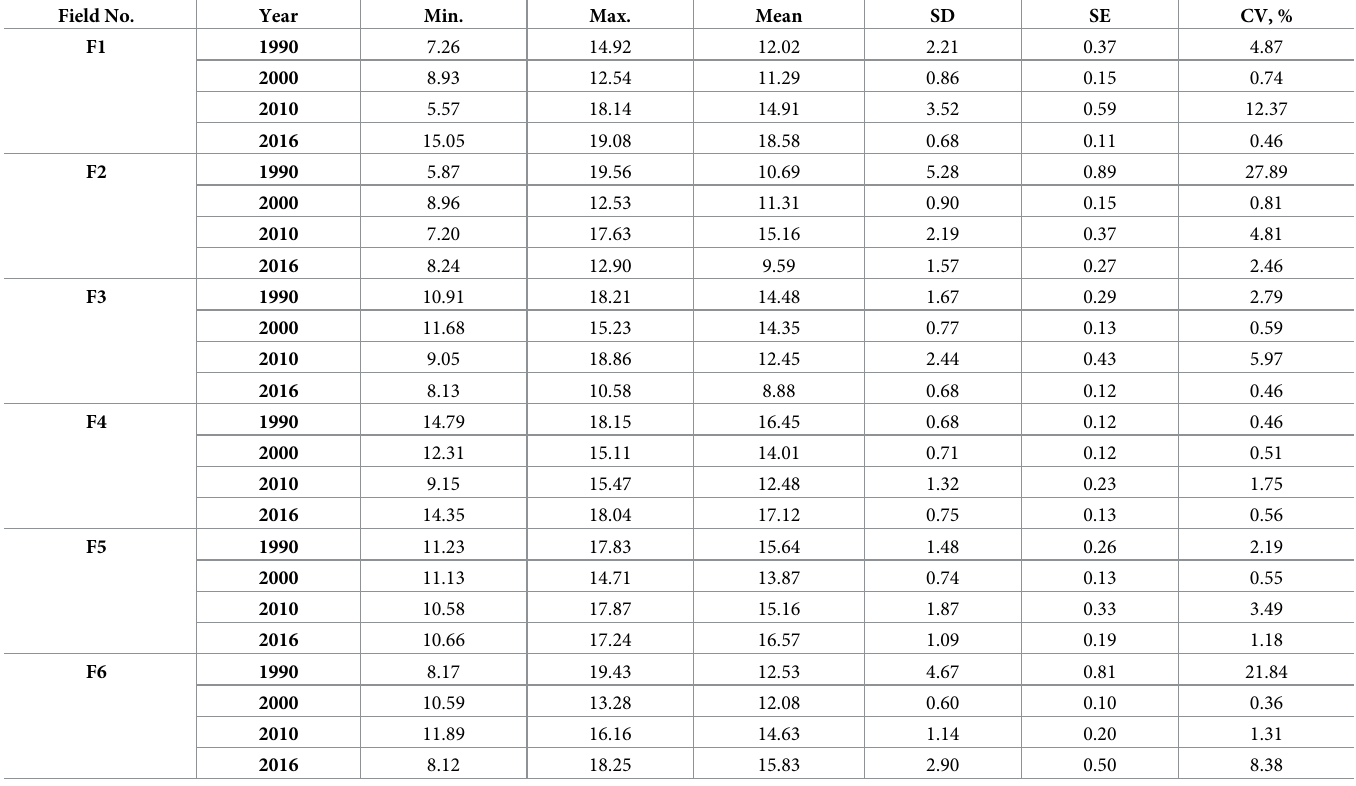
Table 7. Descriptive statistics of the SOC (g kg -1 ) content of the experimental fields. Field